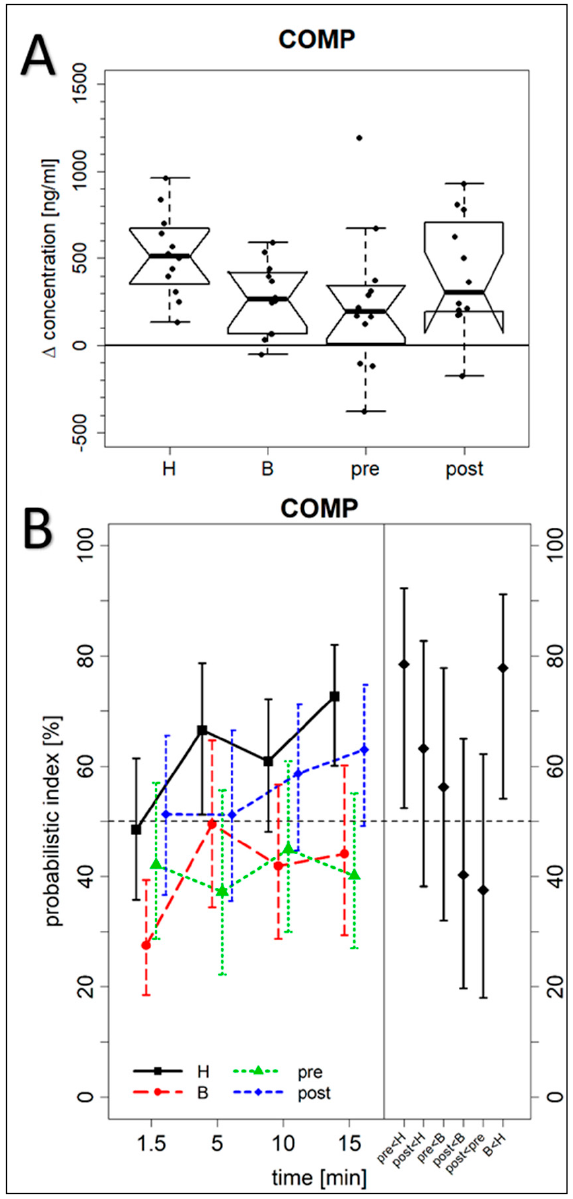
Figure 4. Serum concentrations of COMP. ( A ) The difference between the maximum biomarker concentrations within the first 15 min after exercising of the hand and finger joints and the COMP level at baseline before exercising were calculated (H = cohort of patients with more Heberden-accentuated hand OA ( p = 0.0005; n = 12); B = cohort of patients with more Bouchard-accentuated hand OA ( p = 0,0042; n = 12); pre = premenopausal control group ( p = 0.04; n = 12); and post = postmenopausal control group ( p = 0.001; n = 12)). For further details see the caption of Figure 2A. ( B ) Fully analogous to Figure 2B, but here for COMP